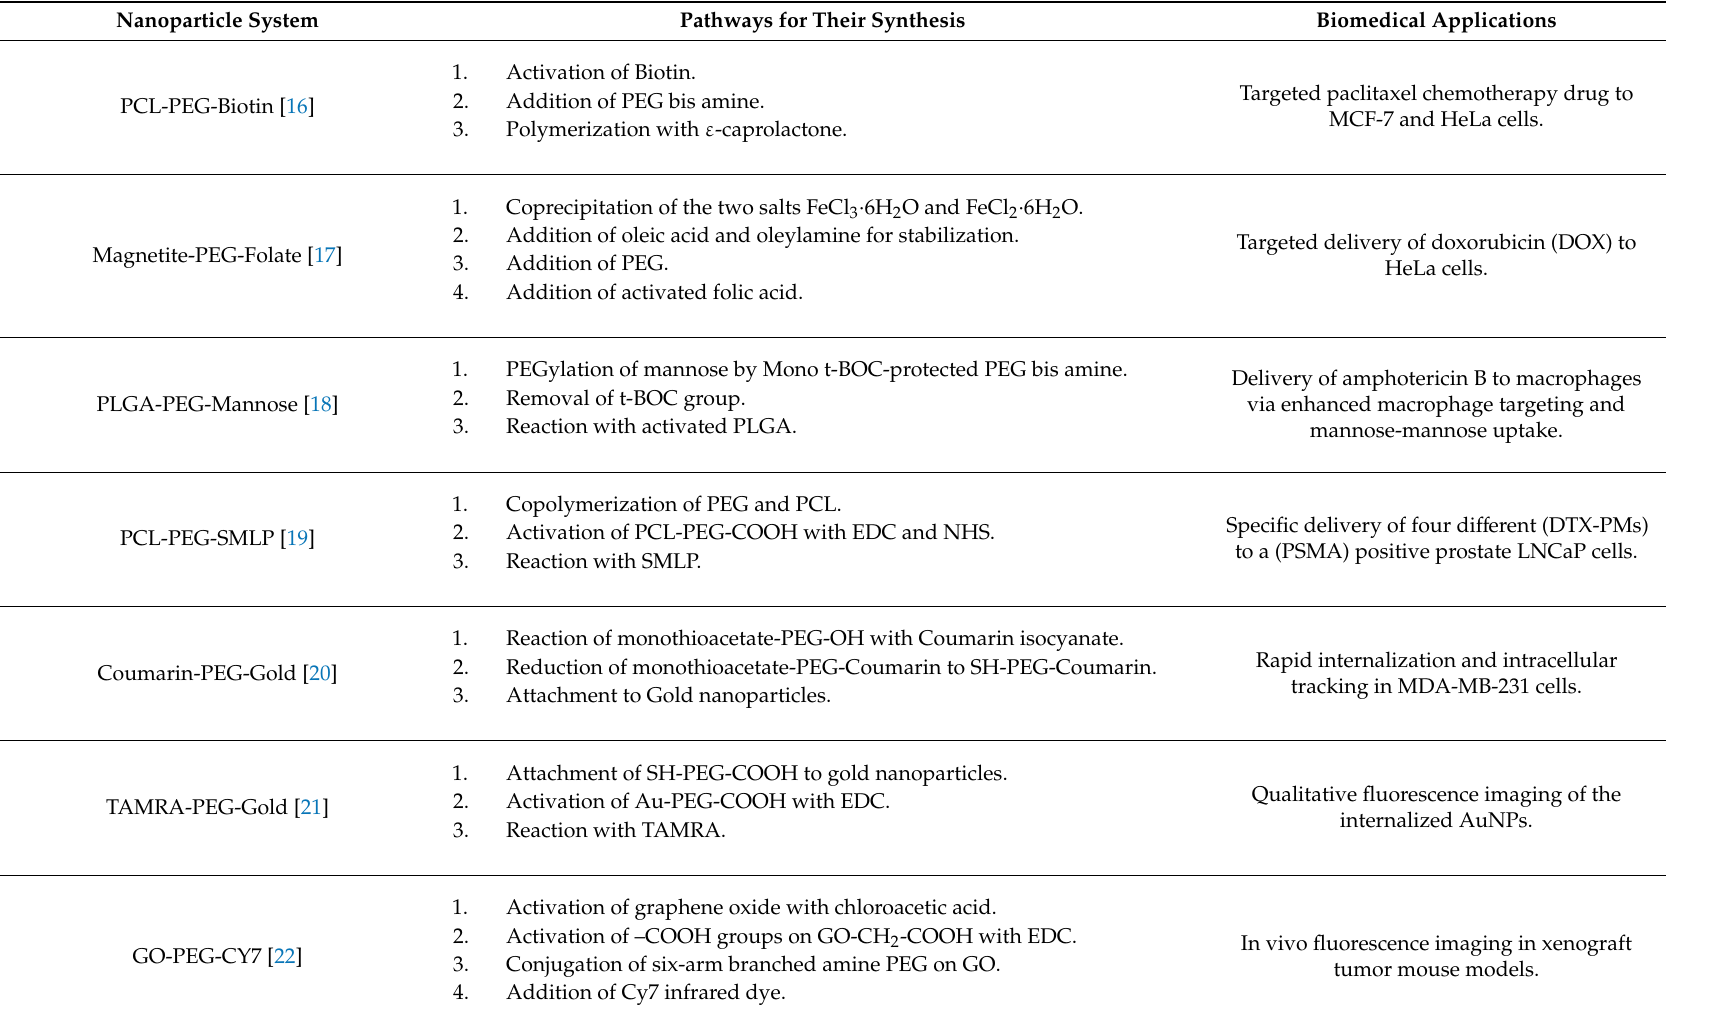
Table 1. The nanostructures presented in this review and their preparation